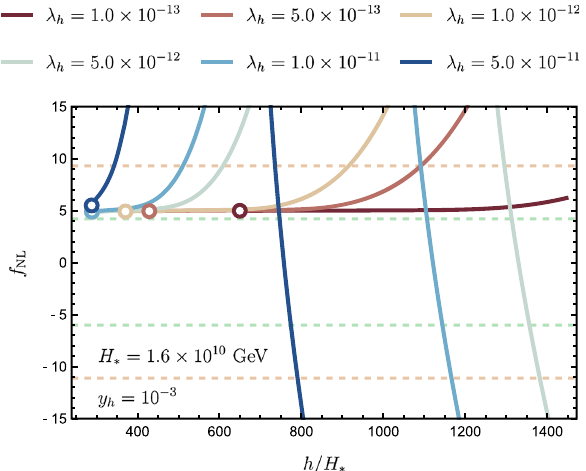
Fig. 3 Thelocalnon-Gaussianityparameter f NL atthepivotscale k ∗ = 0 . 05 Mpc − 1 . The green and orange horizontal dashed lines indicate the 1 σ and 2 σ confidence intervals of the Planck data [33], respectively